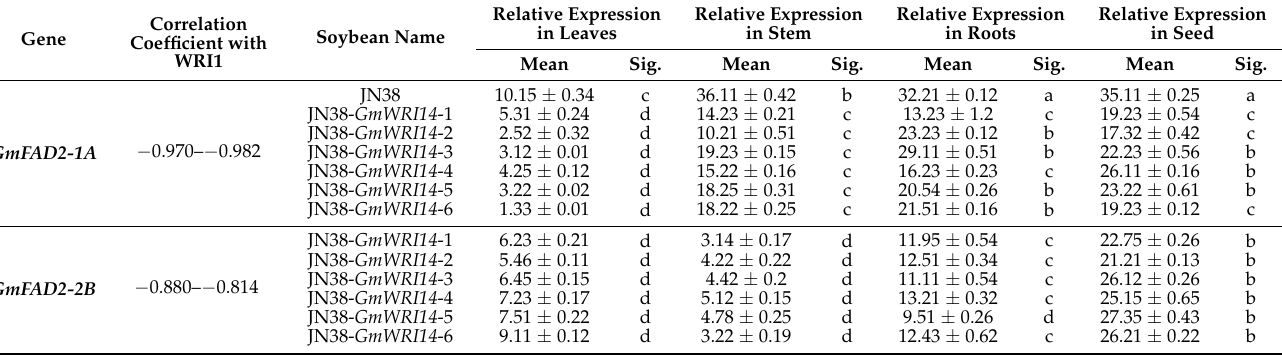
Table 1. Analysis of GmFAD2-1A and GmFAD2-2B expression in different tissues of transgenic